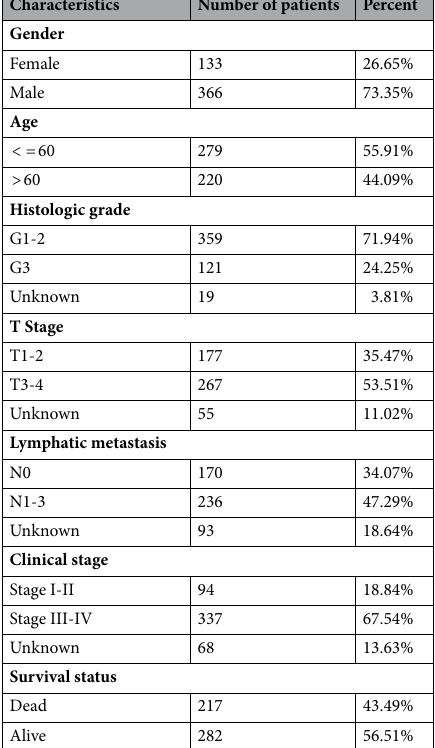
Table 1. Clinical features of the patients with